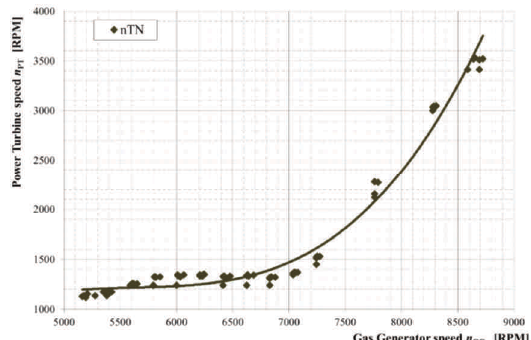
Fig. 6. Approximated function and the results of the measurements of power turbine speed n PT , recorded for steady-state operation of LM-2500 engine, in relation to gas generator speed n GG